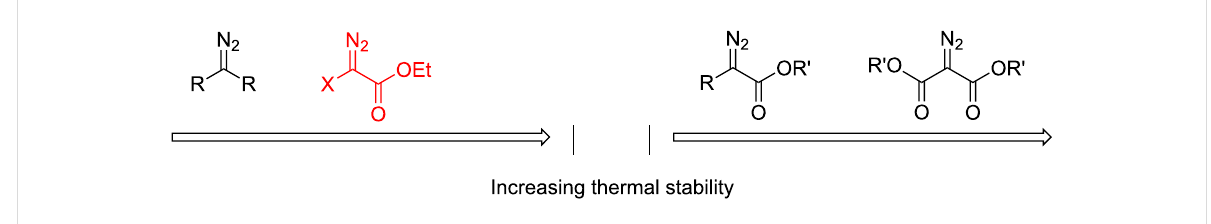
Figure 7: Relative thermal stability of halodiazoacetates (red color).